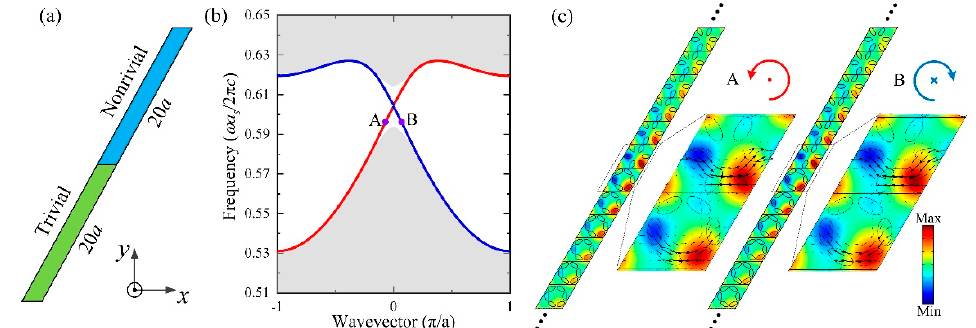
Figure 3. ( a ) Schematic of a ribbon-shaped supercell consisting of 20 radical configuration and 20 azimuthal configuration for the nontrivial and trivial regions, respectively. ( b ) Calculated band structure of the supercell, where periodic (absorbing) boundary conditions were imposed on the right and left (top and bottom) boundaries, respectively. The red (blue) curve represents the pseudospin-up (pseudospin-down) edge state, whereas the shadow regions indicate the bulk photonic bands. ( c ) The corresponding electric field distribution of the edge states localized at the interface of the supercell corresponding to the points A and B in ( b ). Black arrows represent the time-averaged Poynting vector.